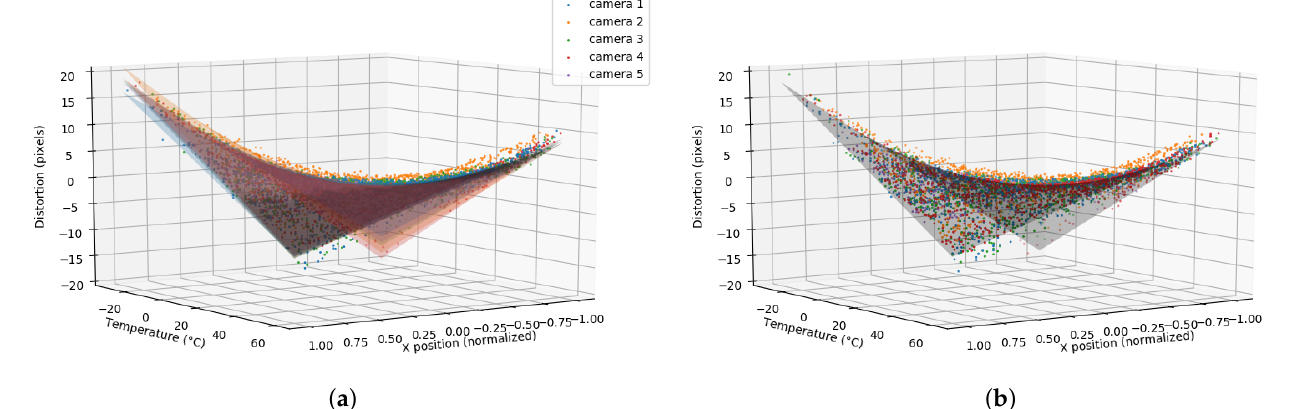
Figure 8. ( a ) The temperature model regression for the five evaluated Orbbec Astra cameras. Each camera has been represented in a different colour. The colour dots correspond to the distortion measurements whereas the surface represents the hyperbolic paraboloid function that has been obtained using the least squares approach. ( b ) The distortion model obtained from the average of all specific camera